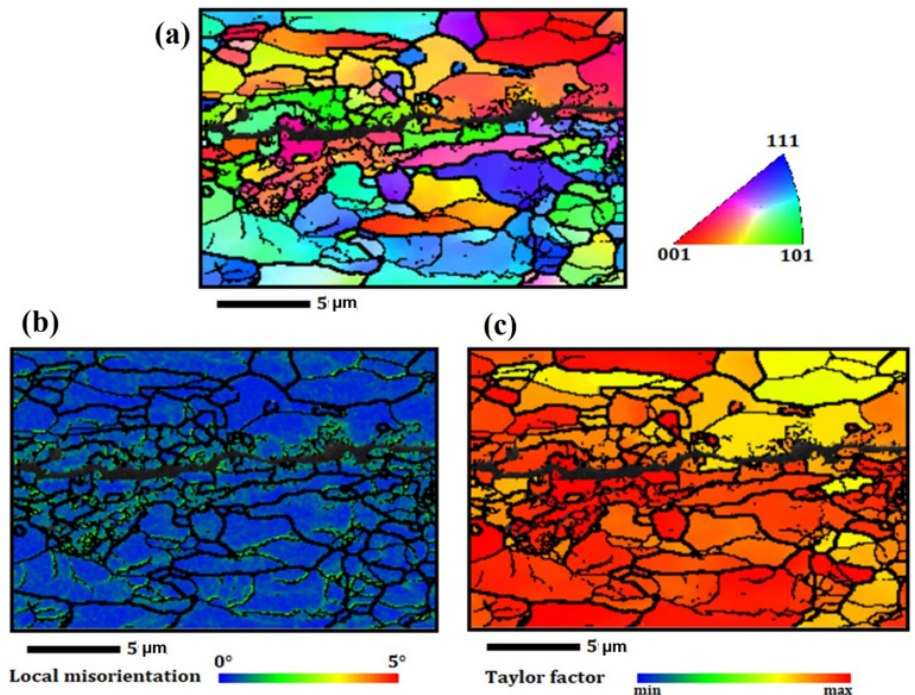
Figure 5. ( a ) Normal direction orientation image, ( b ) Kernel average misorientation, and ( c ) Taylor factor maps of the SOHIC tested specimen. Table 2. Peak parameters such as crystallite size ( D ), dislocation density ( δ ), micro-strain ( ε ) for five sub-peaks using the self-made numerical process of Gaussian multiple of the SOHIC tested